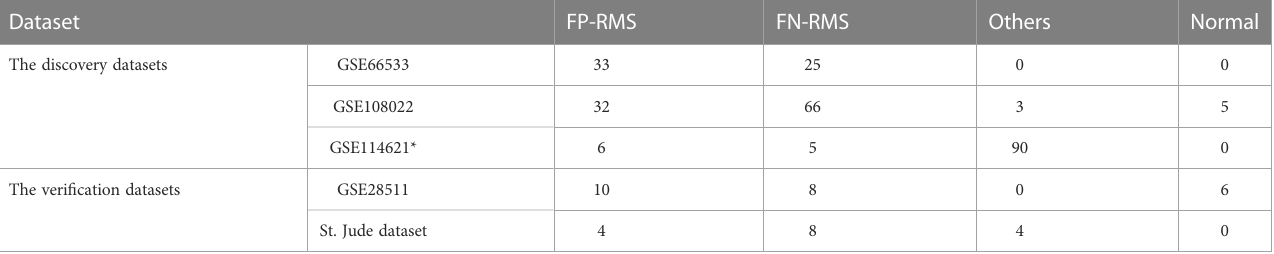
TABLE 1 Demographic of RMS samples and their PAX-FOXO1 fusion status in the cohorts used in the study. Dataset FP-RMS